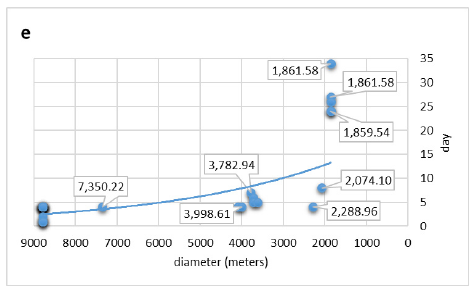
Figure 6. Spatiotemporal evolution of the geo-consensuses related to determining the locations for the zoning of street prostitution. Questions 1 ( a ); 2 ( b ); 3 ( c ); 4 ( d ) and 5 ( e ).